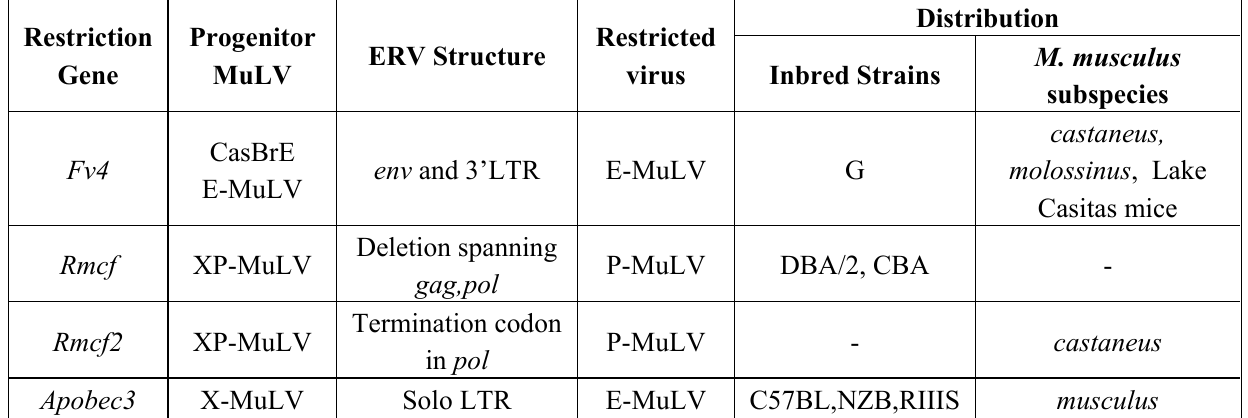
Table 4. MuLV ERVs associated with restriction of exogenous